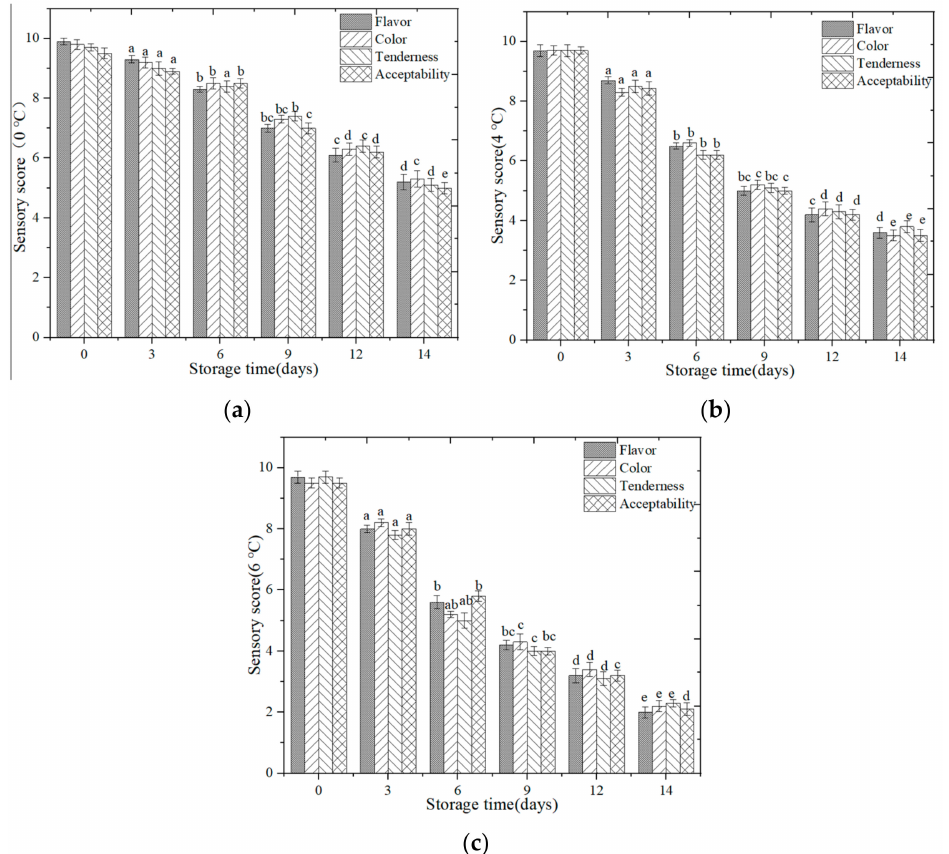
Figure 9. Sensory change of salmon samples ( a ) Sensory change analysis of the flavor, color, tenderness, and overall acceptance at 0 ◦ C; ( b ) Sensory change analysis of the flavor, color, tenderness, and overall acceptance at 4 ◦ C; ( c ) Sensory change analysis of the flavor, color, tenderness, and overall acceptance at 6 ◦ C. Note: Di ff erent letters indicate significant ( p < 0.05) di ff